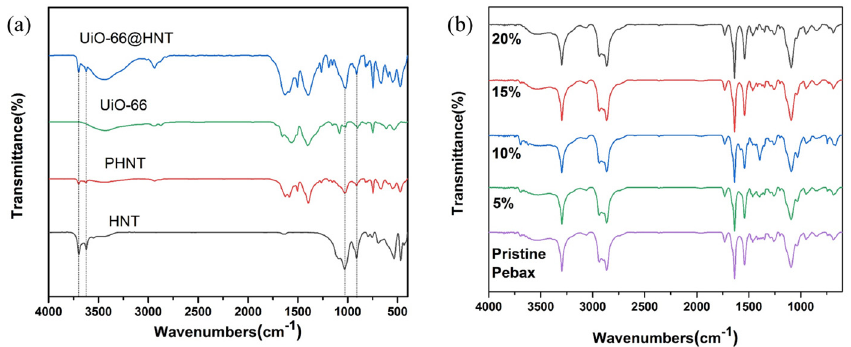
Figure 3. FTIR spectrum of: ( a ) HNT, PHNT, UiO-66, and UiO-66@HNT; ( b ) Pristine Pebax and UiO-66@HNT/Pebax MMMs with different loadings. UiO-66@HNT/Pebax MMMs with different